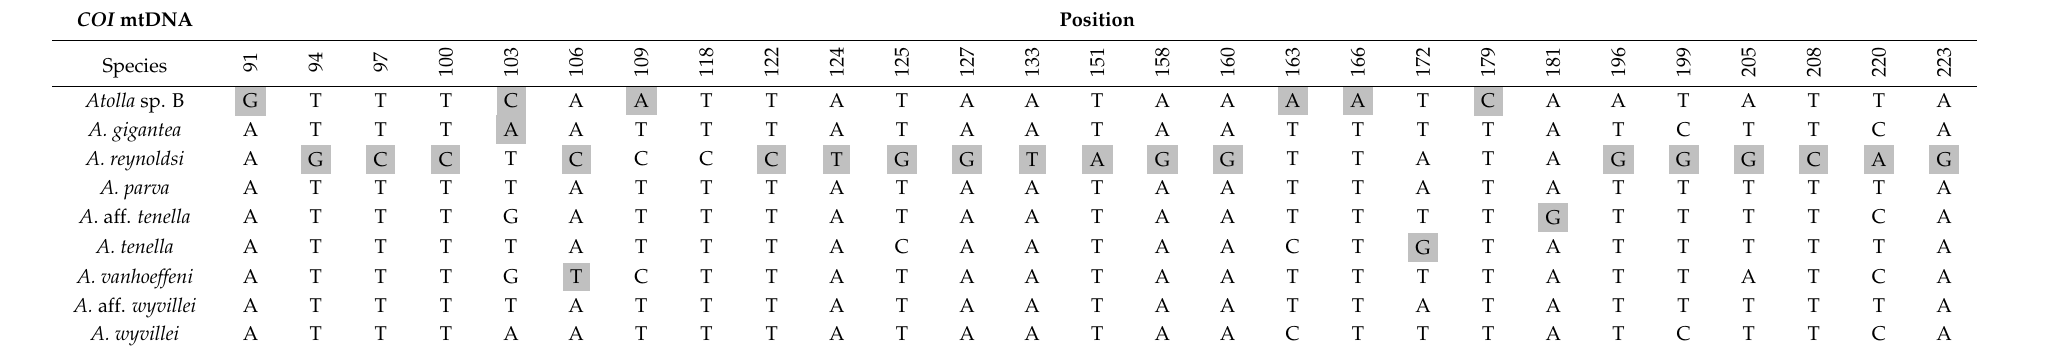
Table A3. Fixed differences for each Atolla species for COI barcode sequence (shaded in gray). Position refers to base pair position in alignment with A. wyvillei